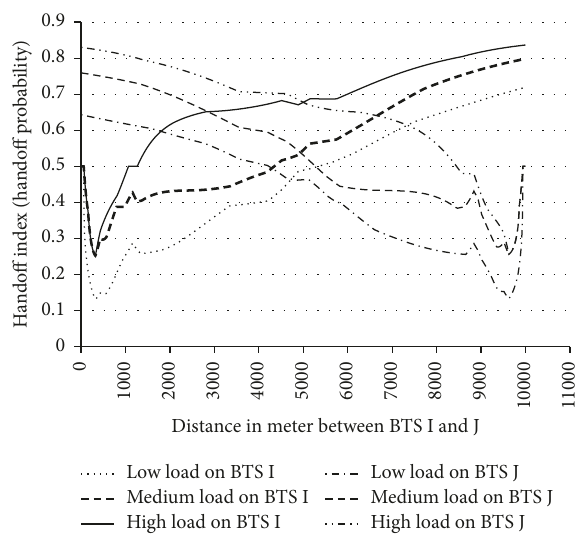
Figure 8: Movement of the mobile station between two adjacent BTSs I and